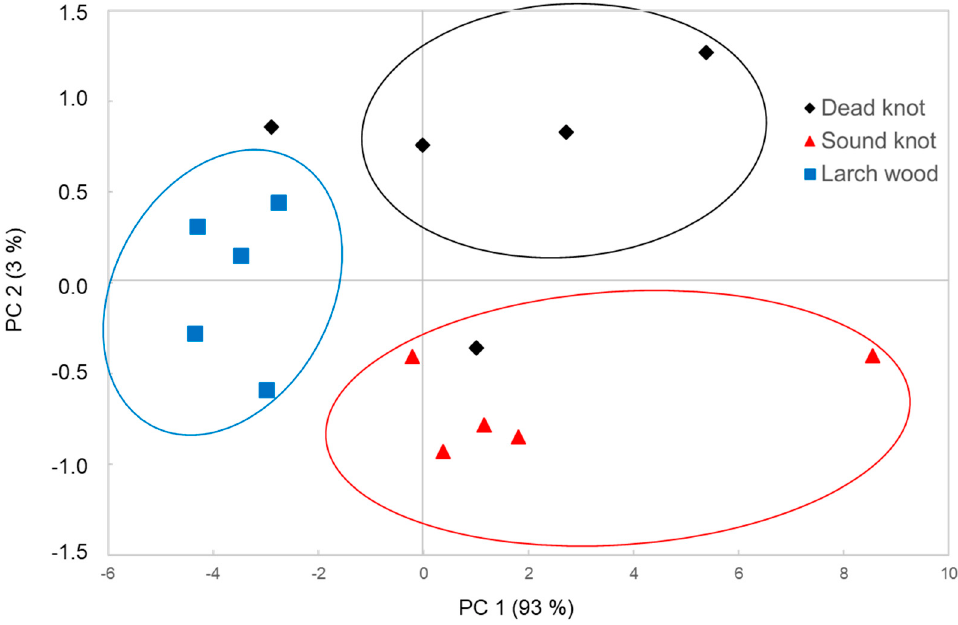
Figure 7. Principal component (PC) analysis score plot of untreated NIR spectra of various larch wood types (e.g., mixture wood, sound and dead knotwood).